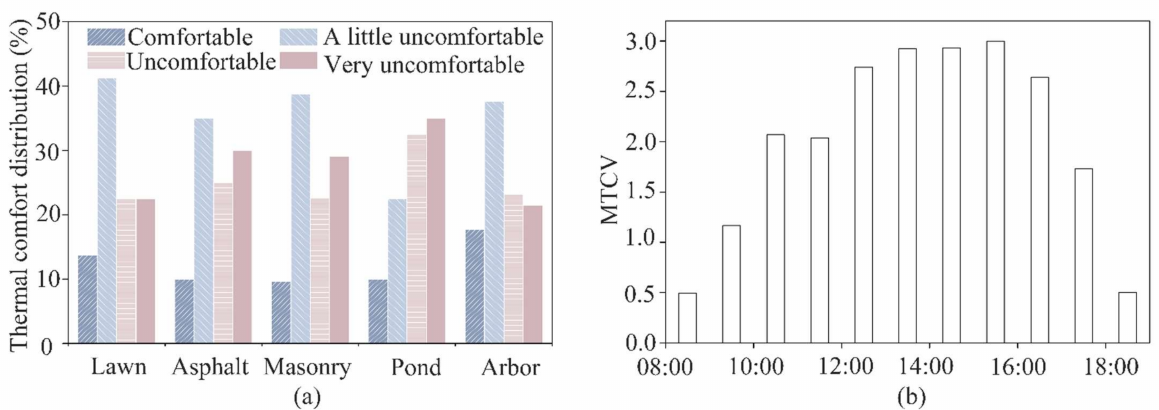
Figure 5. ( a ) Spatial and ( b ) temporal distributions of thermal comfort vote